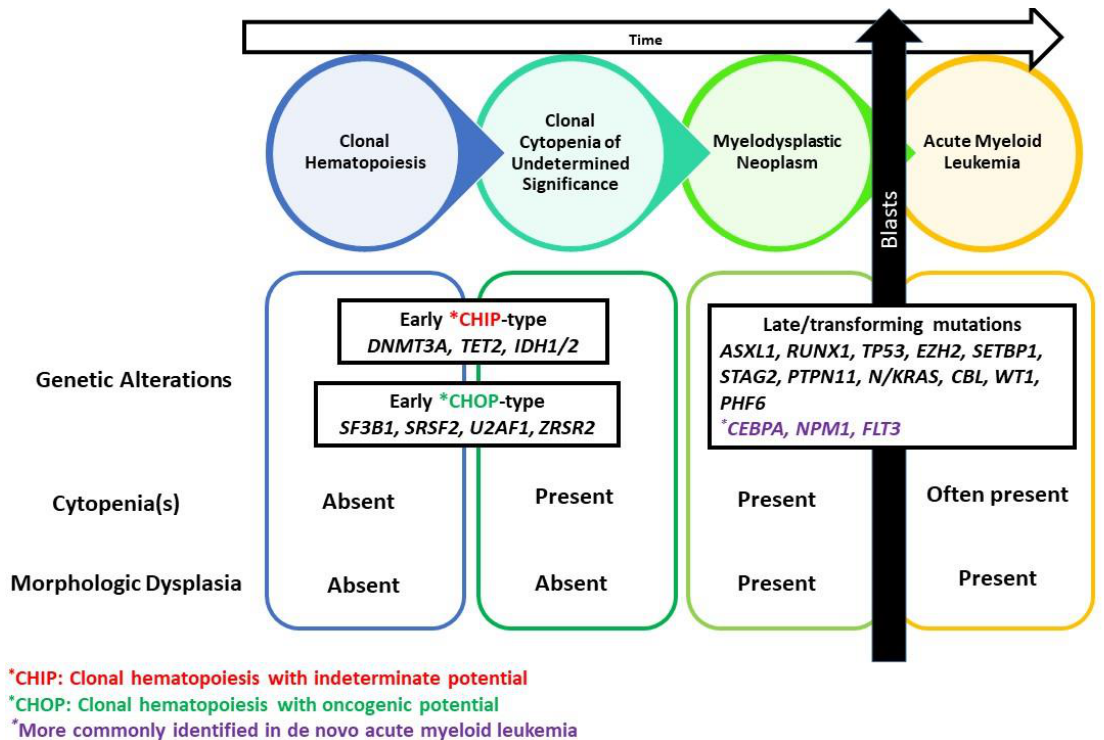
Figure 2. Mutations contributing to myelodysplastic neoplasms (MDS) disease establishment and progression. Clonal hematopoiesis of indeterminate potential or oncogenic potential harboring ancestral and/or founder mutations in a specific set of genes is characterized by the absence of cytopenia(s) and morphologic dysplasia. Clonal hematopoiesis with acquired persistent cytopenia(s) is defined as CH in the presence of cytopenias but without morphologic evidence of dysplasia. Evidence of morphologic dysplasia in the presence of clonality and cytopenias is diagnostic of MDS. Acquisition of late and/or transforming mutations leads to evolution into acute myeloid